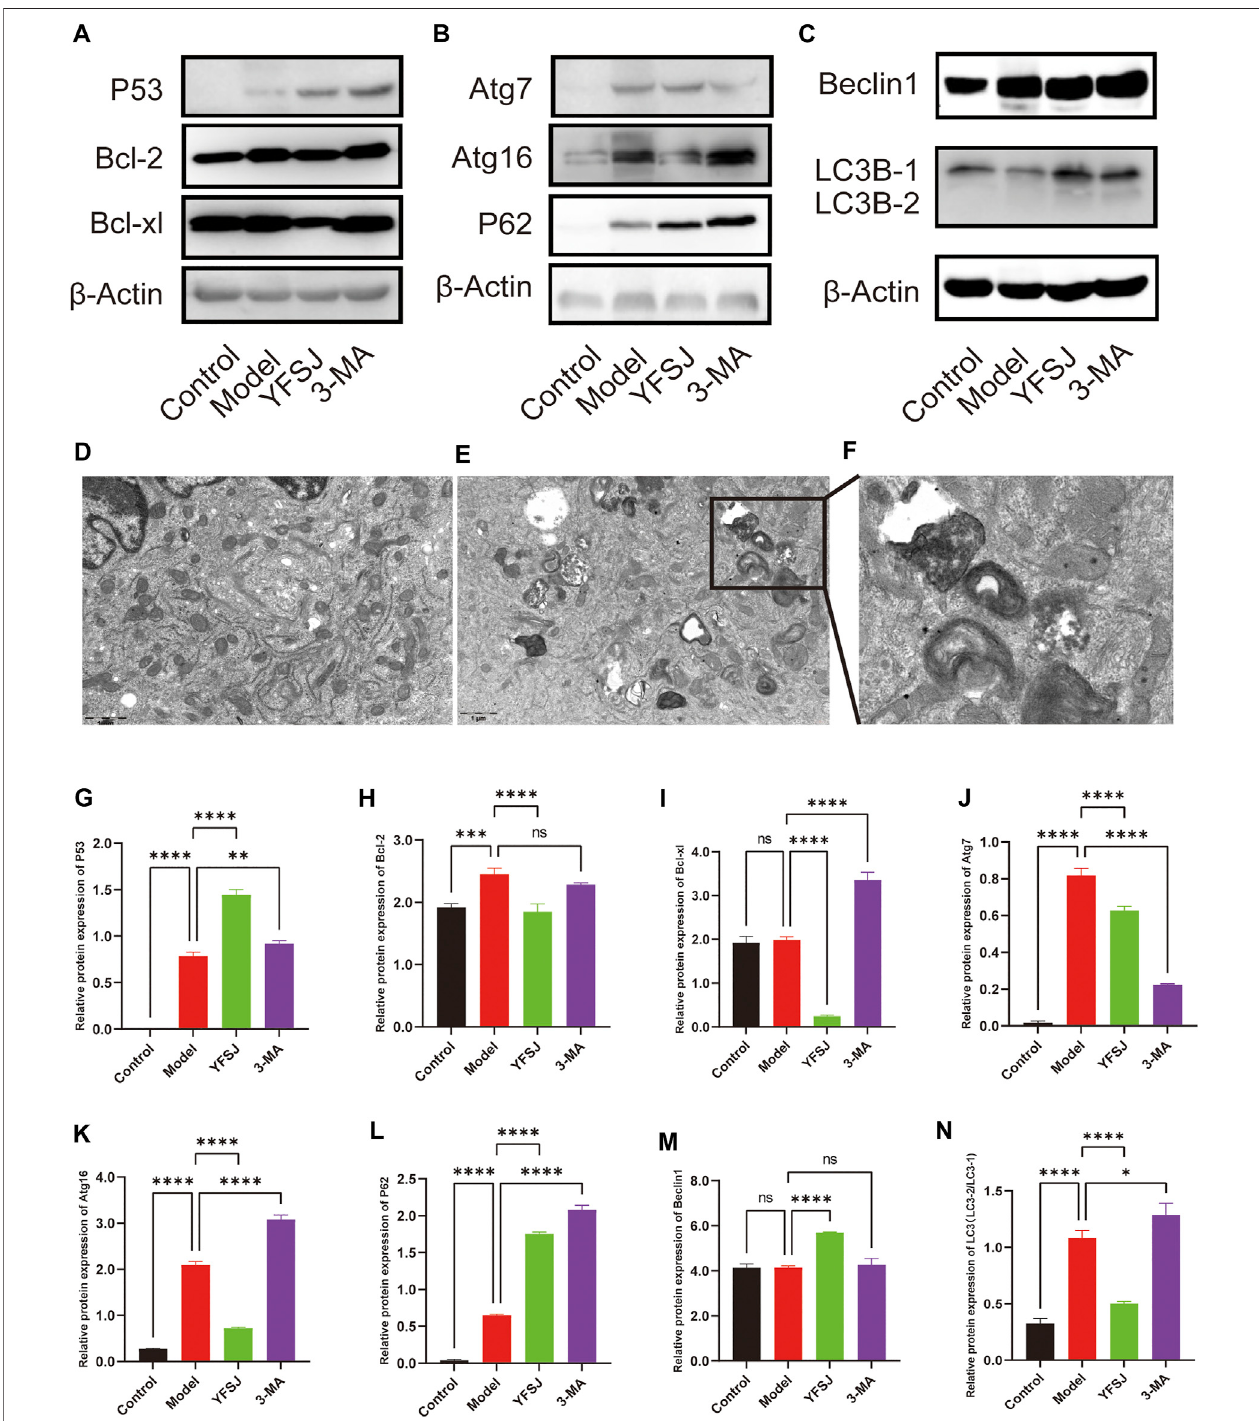
FIGURE6| Westernblotofapoptosis-relatedandautophagy-relatedproteins (A,B,C,G-N) .Transmissionelectronmicroscope(20,000×)ofControl (D) andYFSJ (E,F) treated A549 cell.